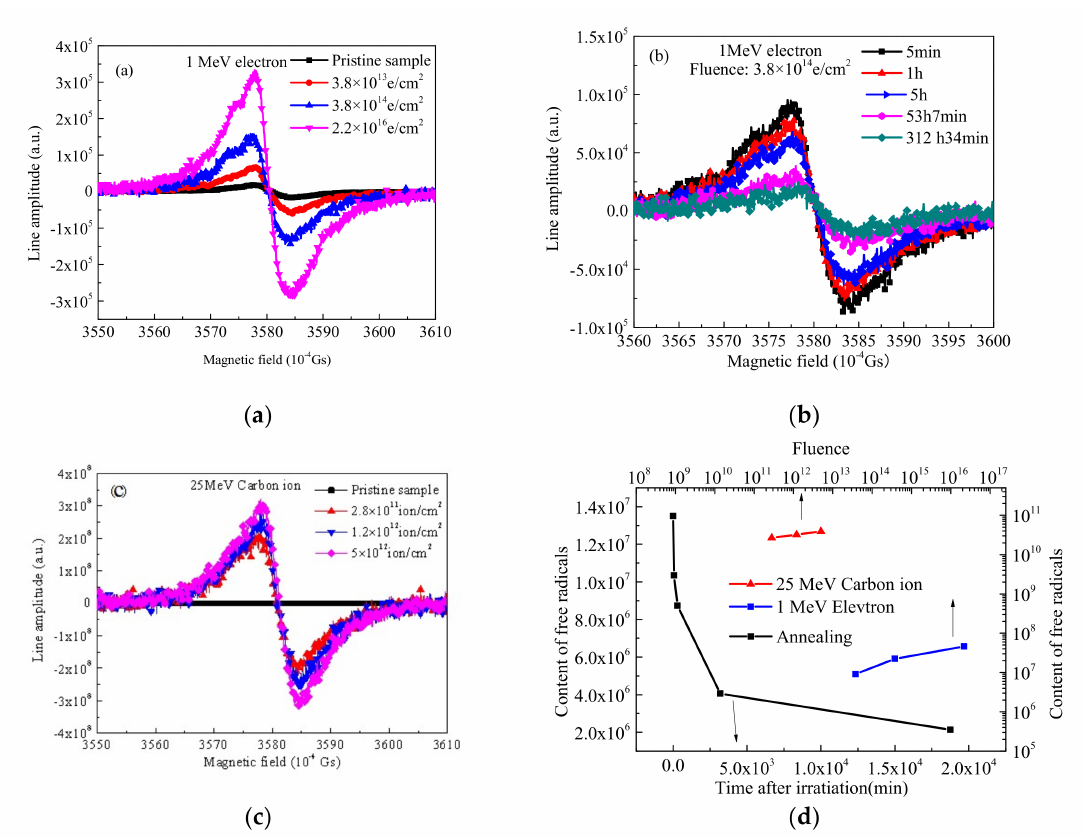
Figure 6. Electron paramagnetic resonance (EPR) curves of the pristine and irradiated PI films with di ff erent sources and fluences: ( a ) 1 MeV electron, ( b ) annealing after 1 MeV electron, ( c ) 25 MeV carbon ion, and ( d ) the change of the content of free